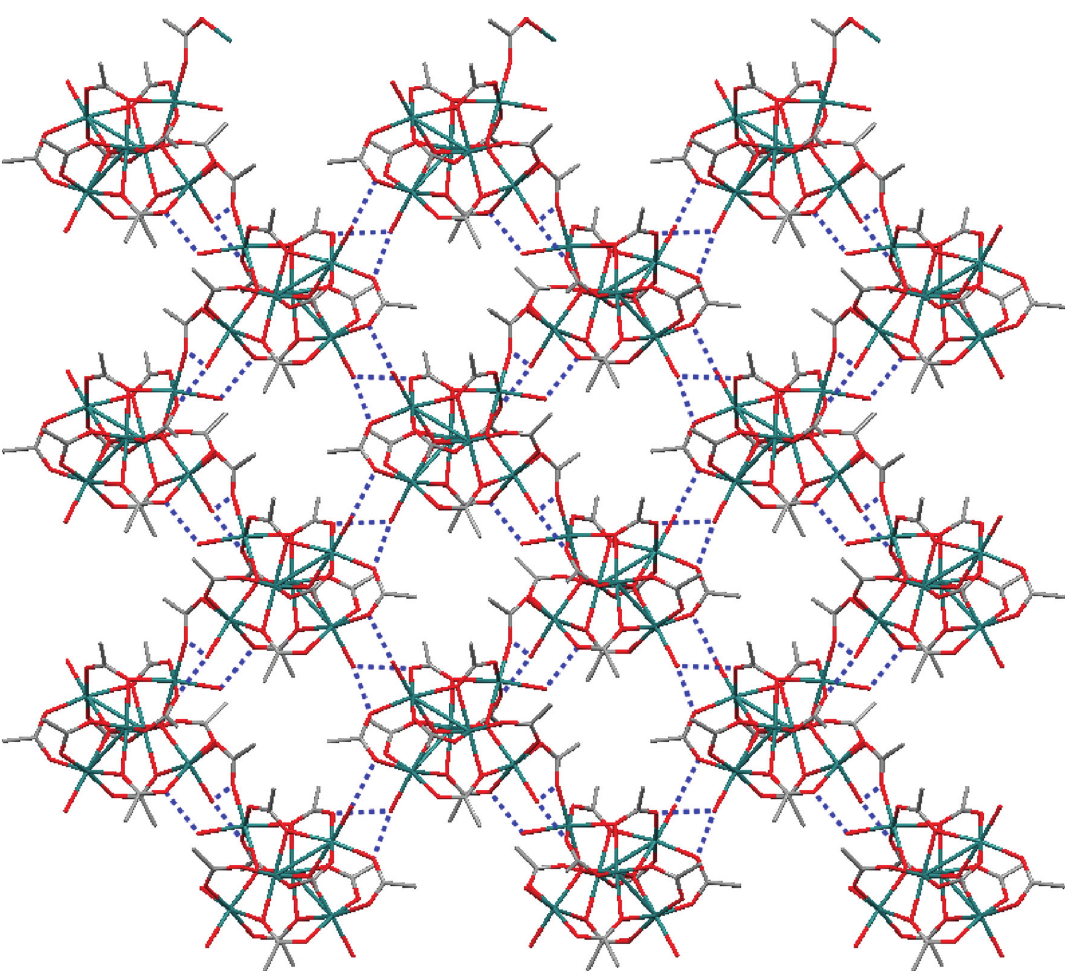
Figure 3: Wireframe representation of the layer formed by interchain hydrogen bonds in ( 1 ) ∞ . The hydrogen bonds are shown as dotted blue lines. Mn, green; O, red; C, grey. H atoms are omitted for